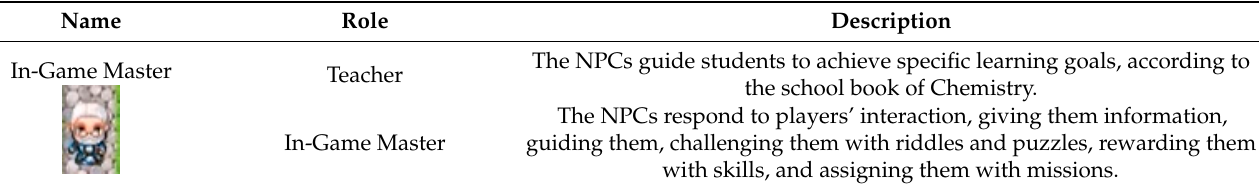
Table 2. Multiplayer Serious Game Personas.